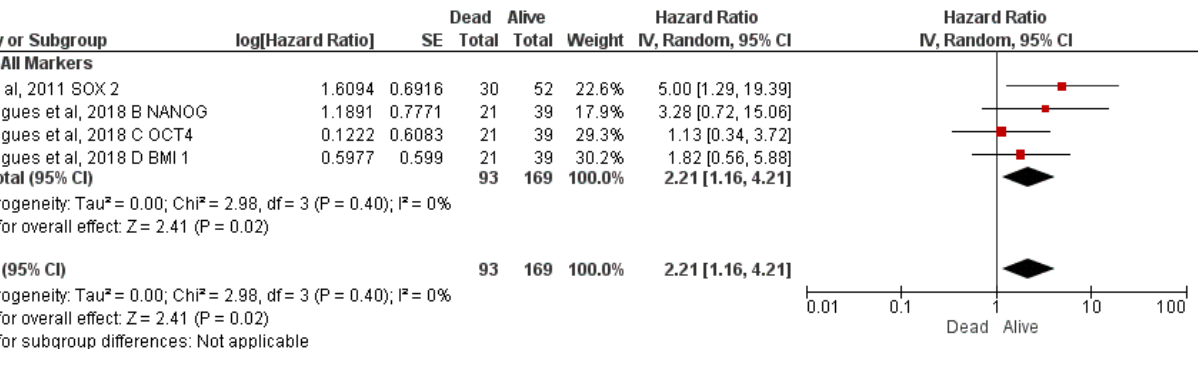
Figure 5. Correlation of CSC markers with overall survival [31,34].